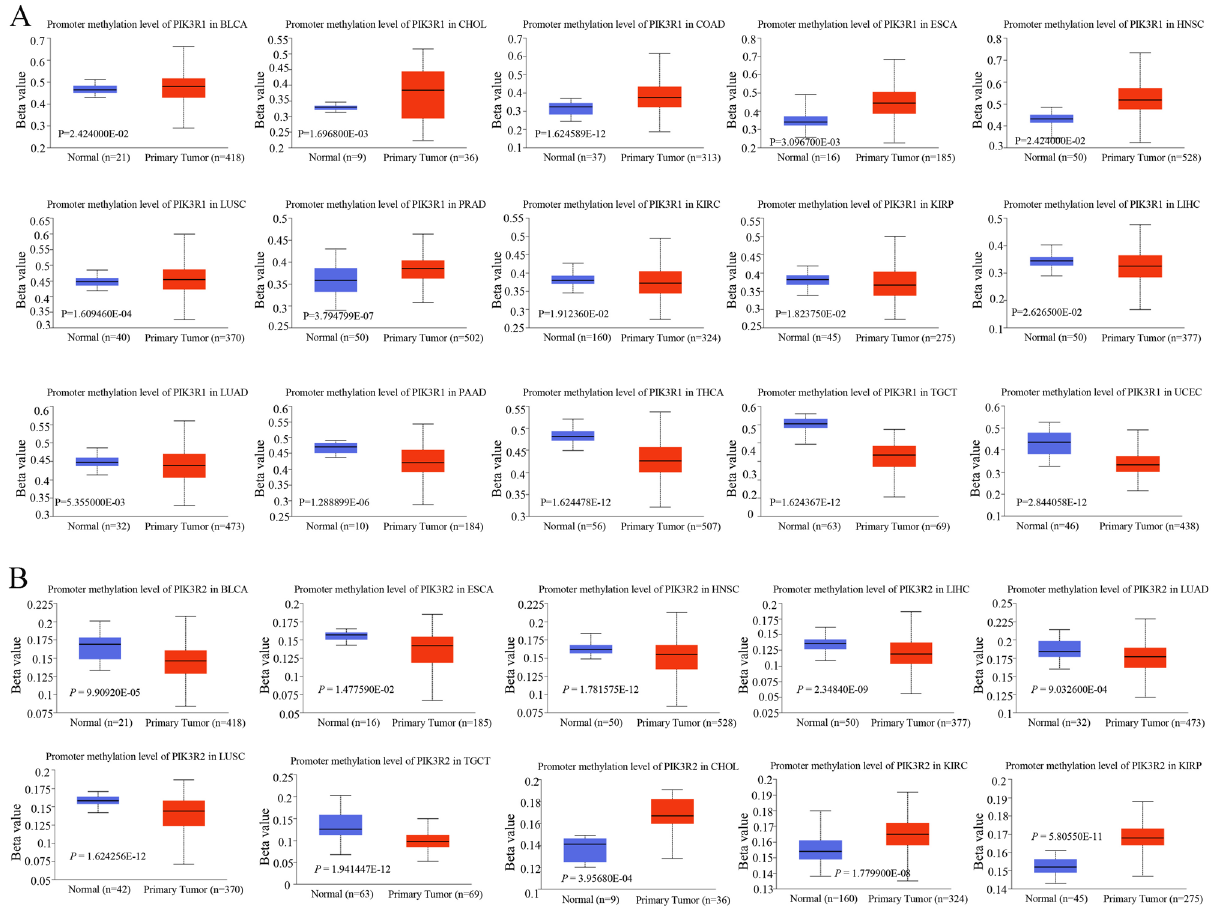
Figure 4. The methylation levels of PIK3R1 and PIK3R2 between normal tissues and different tumor tissues, respectively. Methylation level analysis of genes were conducted by UALCAN database (http:// ualcan. path. uab. edu/ analy sis- prot. html). ( A ) Statistically significant differences exist in the promoter methylation levels of PIK3R1 between normal tissues and tumor tissues including BLCA, CHOL, COAD, ESCA, HNSC, LUSC, PRAD, KIRC, KIRP, LIHC, LUAD, PAAD, TGCT, THCA and UCEC. ( B ) Statistically significant differences exist in the promoter methylation levels of PIK3R2 between normal tissues and BLCA, ESCA, HNSC, LIHC, LUAD, LUSC, TGCT, CHOL, KIRC, and